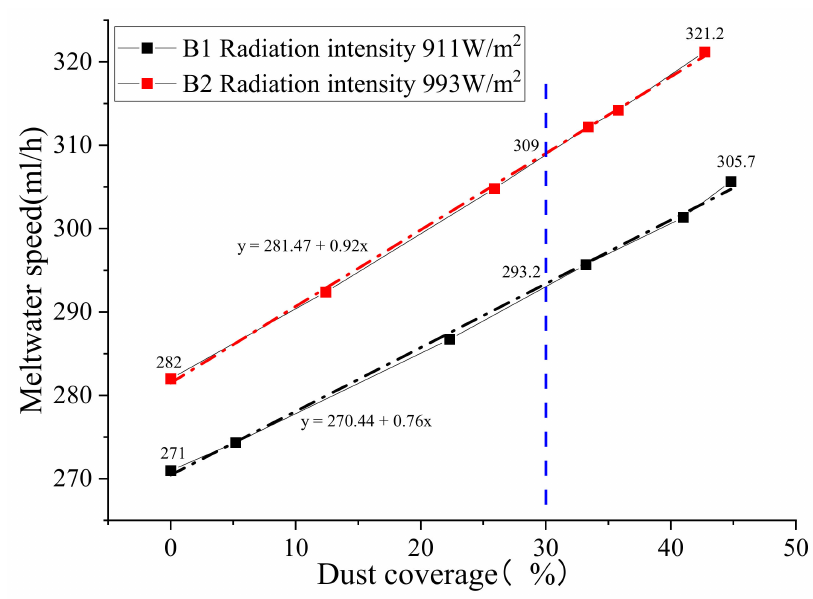
Figure 7. Relationship between the dust coverage rate and meltwater speed (Group